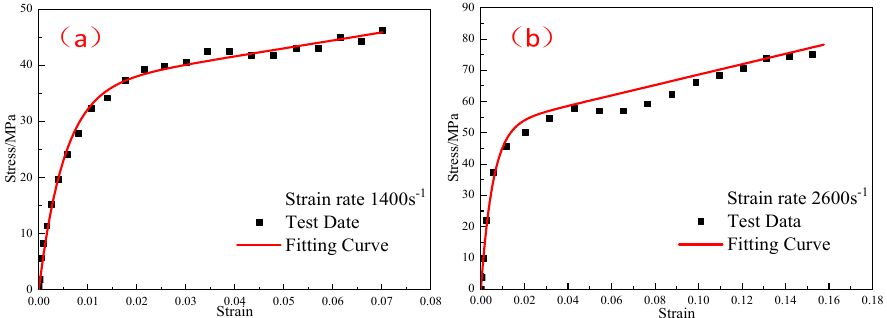
Figure 14. Comparison of the fitting results of the ZWT constitutive model with experimental results under 400 MPa pressing pressure and at different strain rates: ( a ) 1400 s − 1 ; ( b ) 2600 s − 1 . The stress–strain curves of No.14 and No.22 with different strain rates are fitted so as to obtain the elastic constant E 2 and relaxation time θ 2 , which are suitable for strain rates ranging from 1400 s − 1 to 2600 s − 1 when the pressing pressure is 600 MPa. The fitting results are shown in Figure 15. The correlation coefficients R 2 of curve fitting are 0.99 and 0.94, respectively. The fitting results are E 2 = 4.9 GPa, θ 2 = 4.06 µ s.